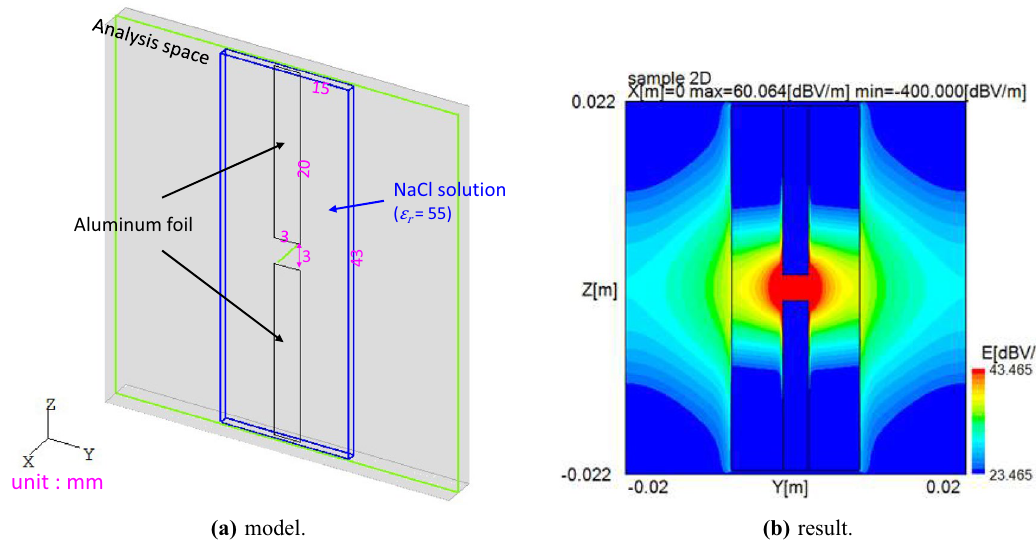
Figure 6. Static electric field analysis of the electrodes with a laminated pH-indicating paper part (applied voltage = 1 V). ( a ) model. ( b ) result.